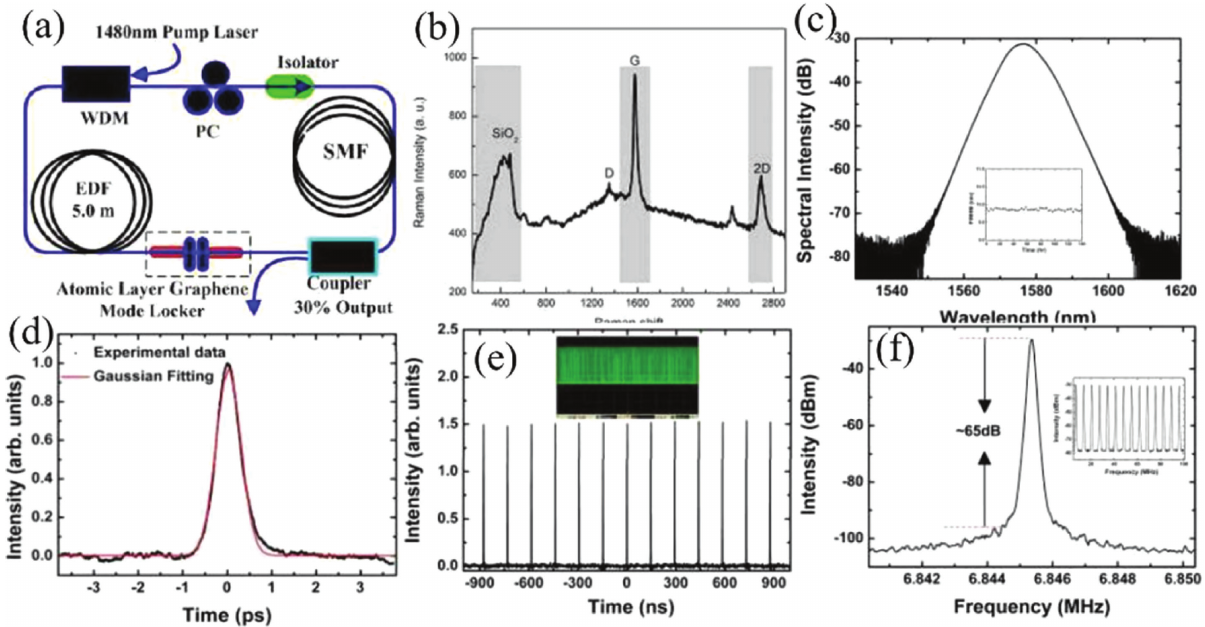
Figure 10: Mode-locked fiber lasers with graphene SA at the 1.55- μ m region. (A) Schematic of the fiber laser. (B). Raman spectra of the graphene film. (C) Optical spectrum. (D) Autocorrelation traces of the pulses. (E) Oscilloscope trace of the single pulse emission. Inset: pulse train of CW mode-locking in millisecond time scale. (F) Fundamental radio frequency (RF) spectrum of the laser output. Inset: wideband RF spectrum up to 100 MHz. Reproduced with permission from Ref. [14]. Copyright 2009, American Chemical